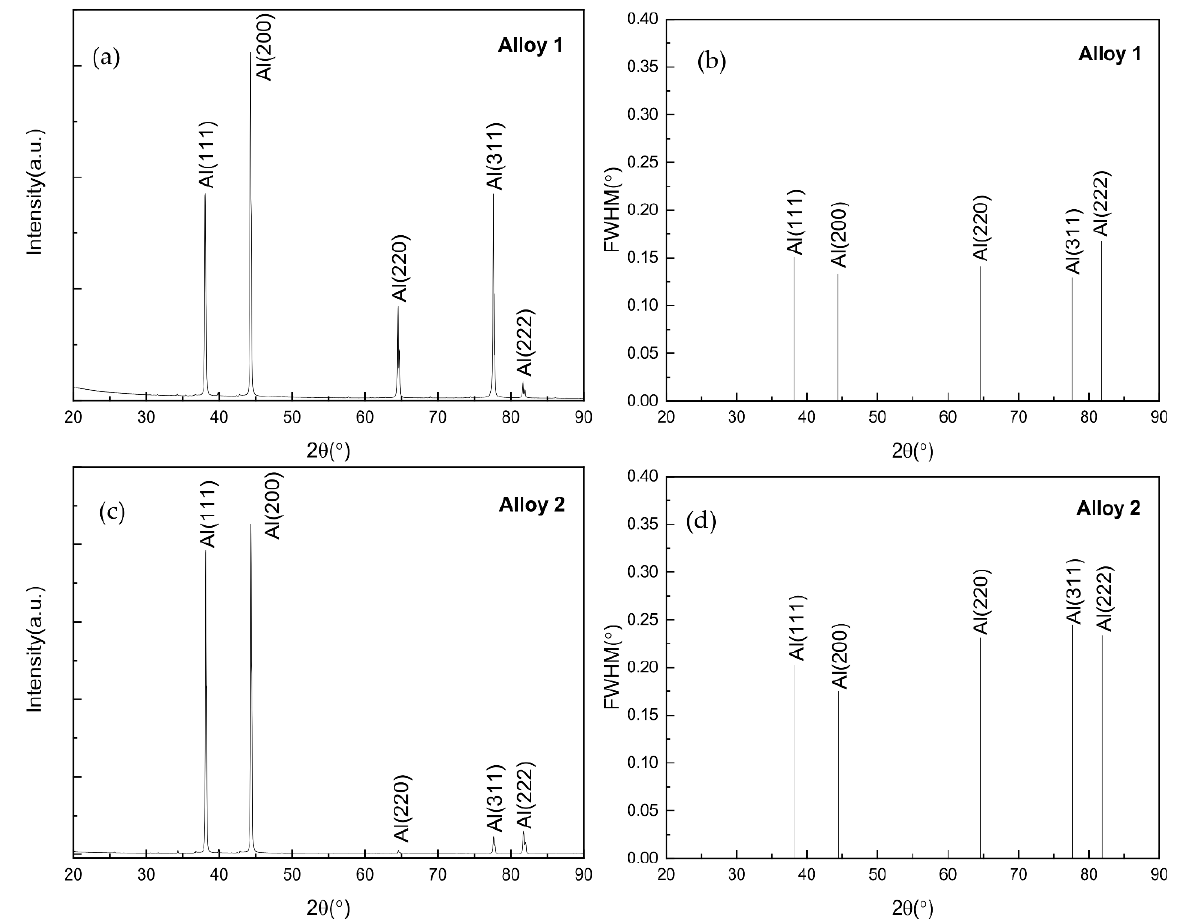
Figure 3. XRD analysis of alloy 1 ( a , b ) and alloy 2 ( c , d ) after hot extrusion: ( a , c ) XRD patterns; ( b , d ) FWHM.